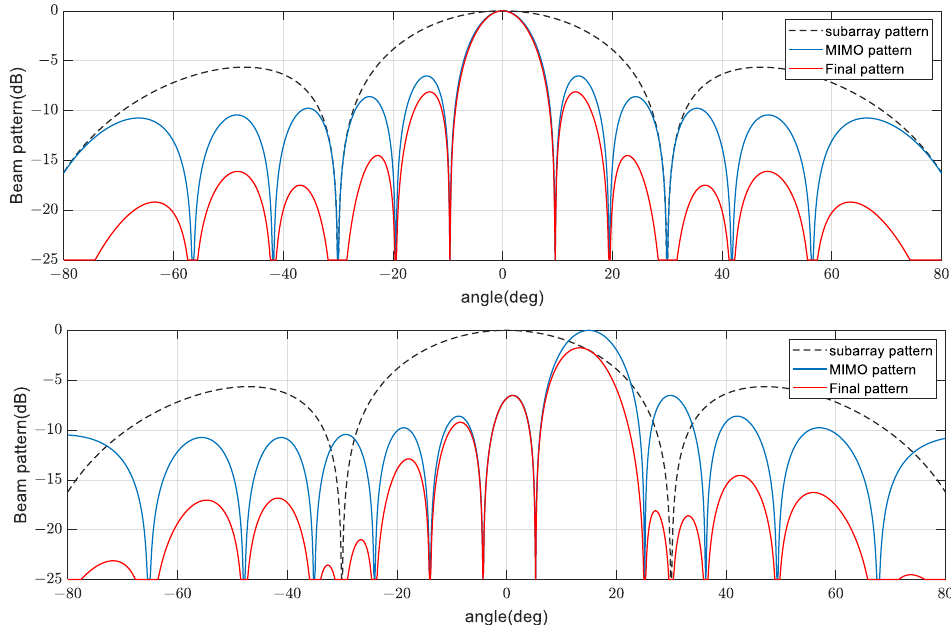
Figure 5. The final beampattern with TX subarrays in the case of steering to 0° ( upper ) and 15° ( lower ).